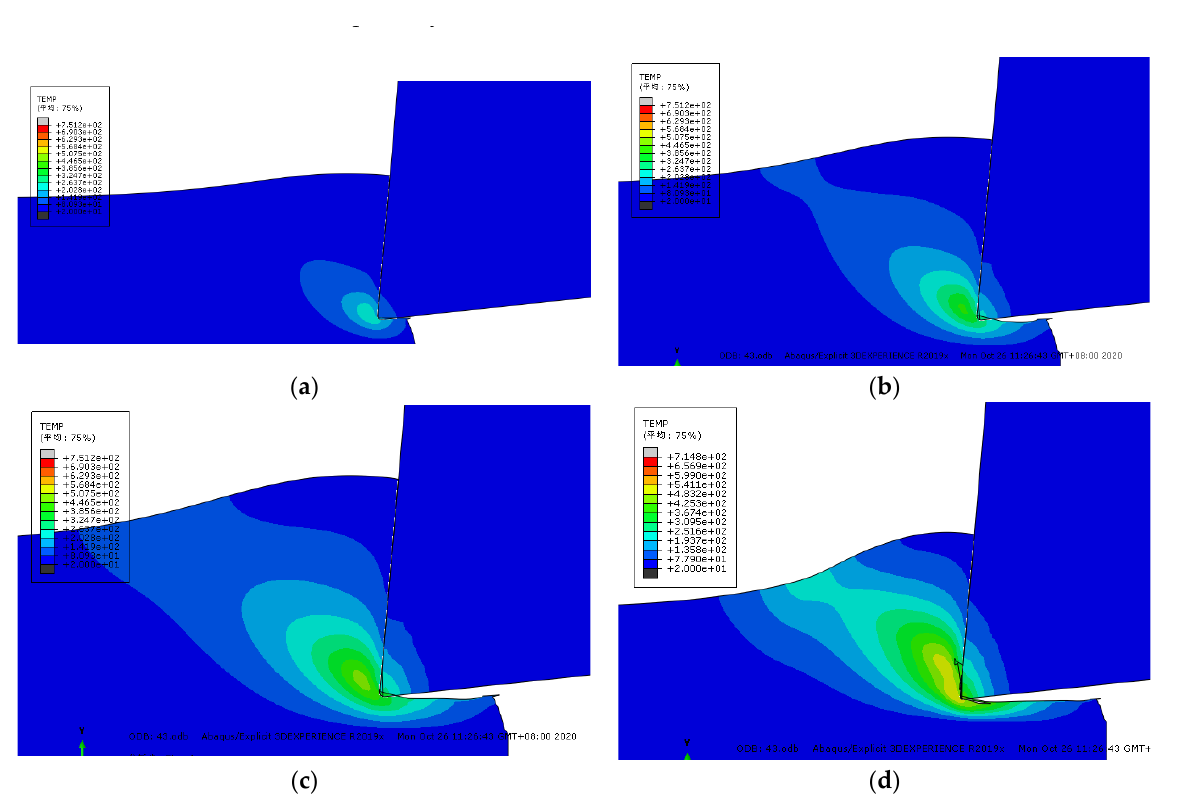
Figure 8. Changes in the cutting temperature field at the beginning of cutting ( ° C). ( a ) t = 5 × 10 – 4 s ( b ) t = 8.8 × 10 – 4 s. ( c ) t = 1.2 × 10 – 3 s ( d ) t = 2.2 × 10 – 3 s.